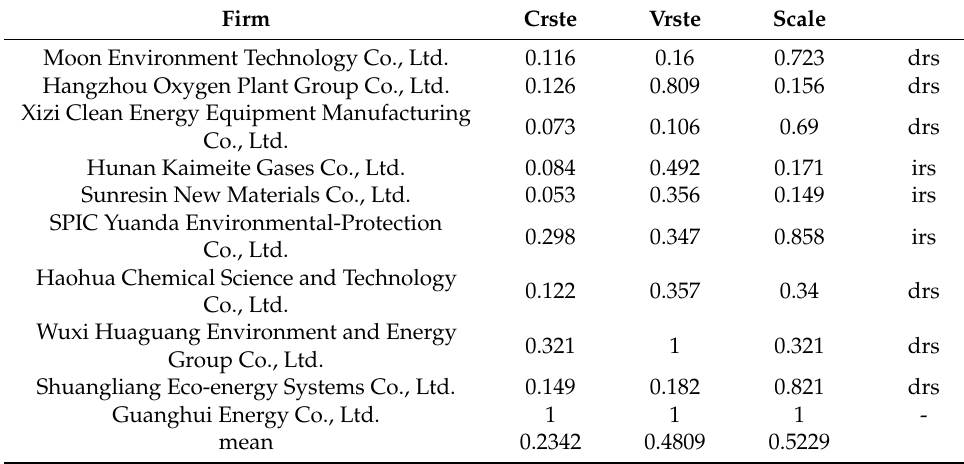
Table 3. 2018 Enterprise